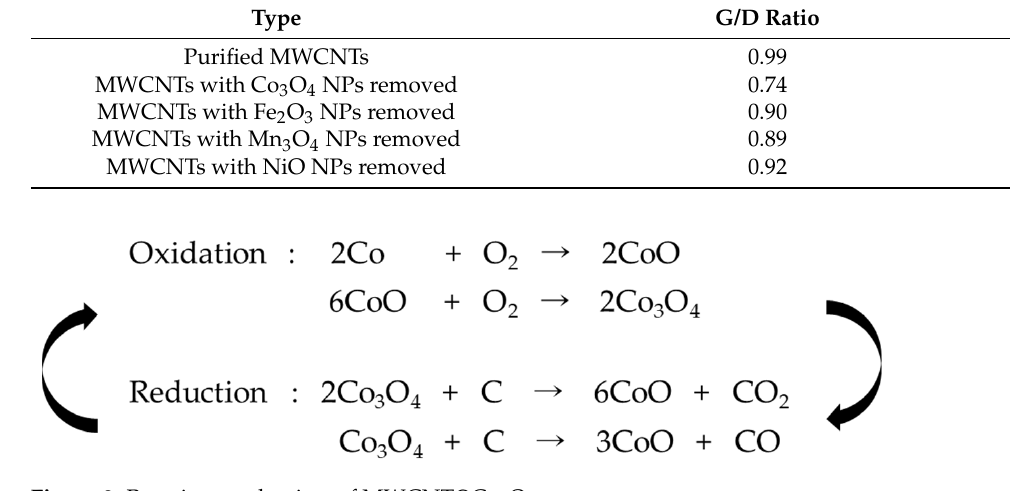
Table 3. Electrical conductivity